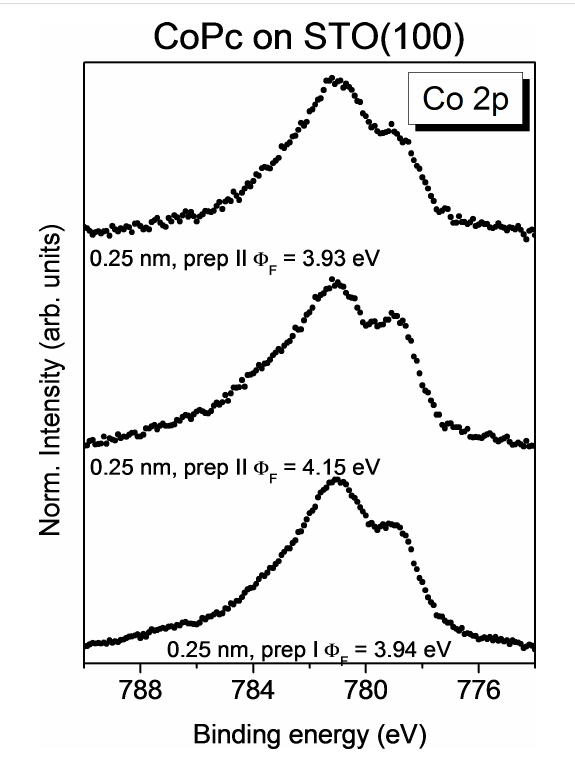
Figure 7: CoPc on STO(100). Co 2p 3/2 core level spectra for a mono- layer of CoPc deposited on differently prepared STO